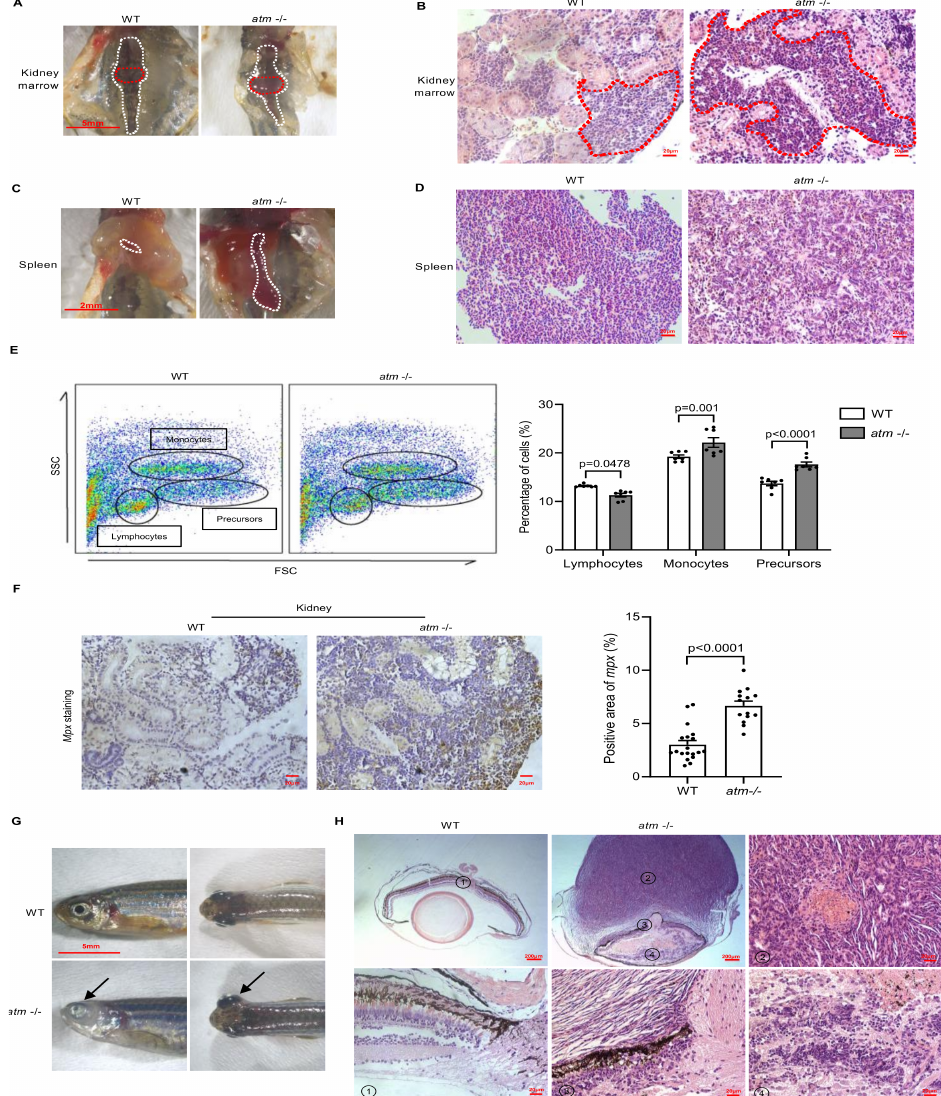
Figure 4. Tumorigenesis in atm − / − zebrafish. ( A ) Kidney marrow anatomy of WT and atm − / − zebrafish. ( B ) HE staining of kidney marrow shown in A. ( C ) Spleen of WT and atm − / − zebrafish. ( D ) HE staining of spleen shown in ( C ). ( E ) Flow cytometry analysis of cells extracted from the kidney of 12-month-old WT and atm − / − zebrafish (left). Quantification of percentage of lymphocytes, monocytes, and precursors (right) (n = 7 for each group). ( F ) Immunochemistry of kidney tumor from atm − / − fish compared to WT kidney (left). Quantification of mpx-positive signals area (right) (n = 19 for WT; n = 14 for atm − / − ). ( G ) Neoplasm in the eyes of atm − / − zebrafish. ( H ) HE staining of neoplasm in the eyes of atm − / − zebrafish compared with the WT eyes. The statistical significance was analyzed using the two-tailed Student’s t-test. Data are shown in means ±